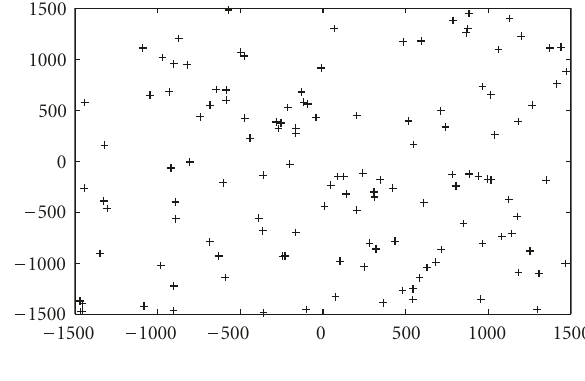
Figure 11: A uniform codebook.